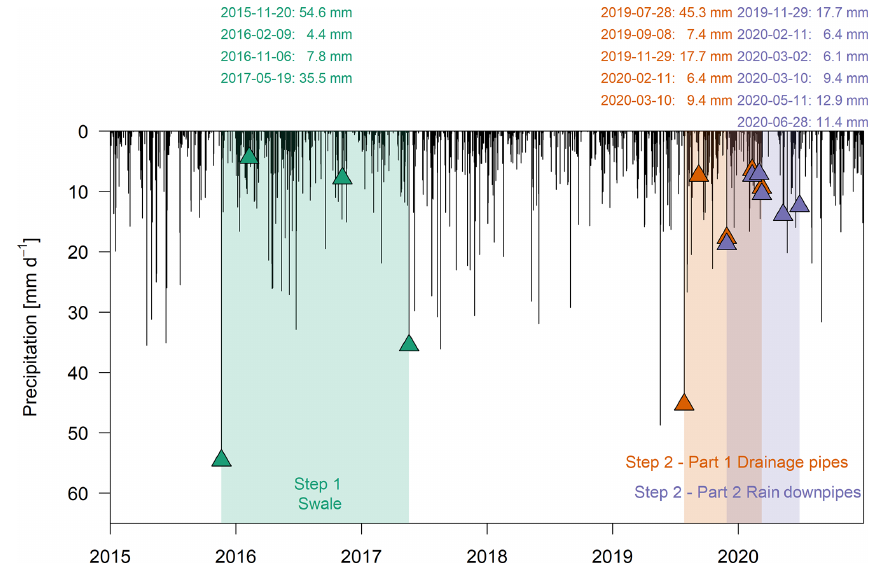
Figure 4. Daily precipitation about 5km away from study site between 2015 and 2020. Sampled events are marked according to the two- step approach. Colors correspond to the steps of the experimental procedure and sampling sites. Precipitation data are from the Deutscher Wetterdienst (Station Freiburg). Table 1. Overview of samples